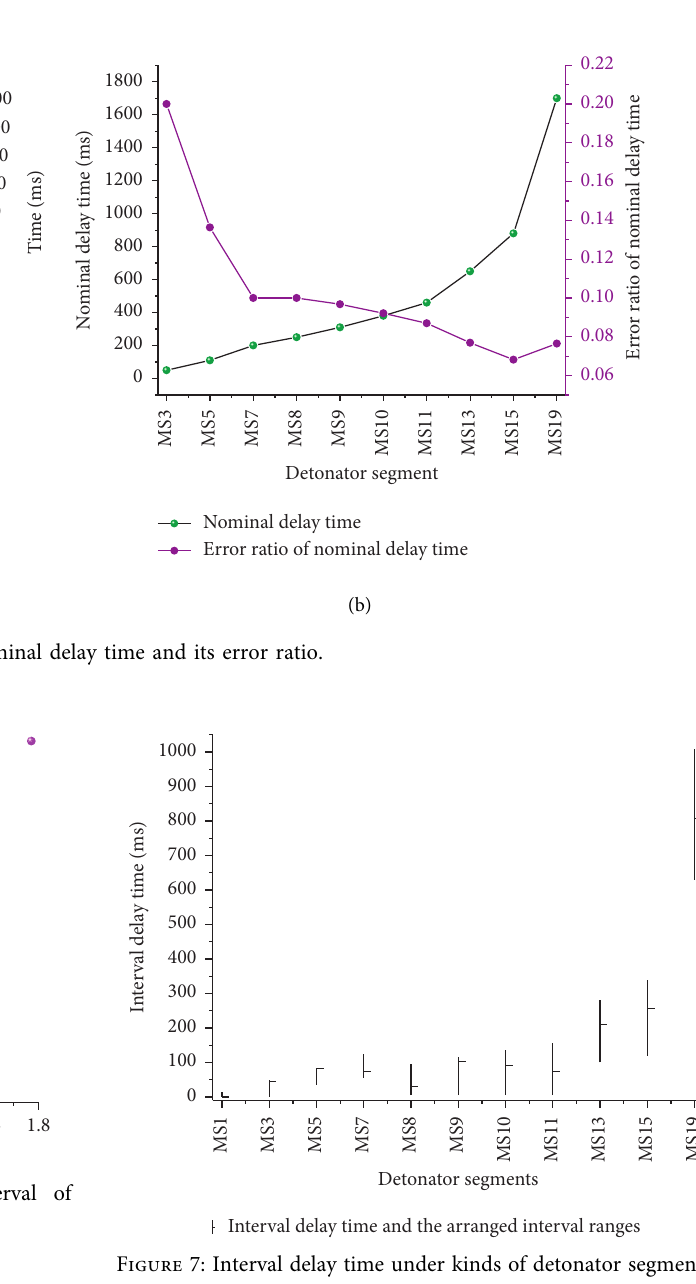
Figure 7: Interval delay time under kinds of detonator